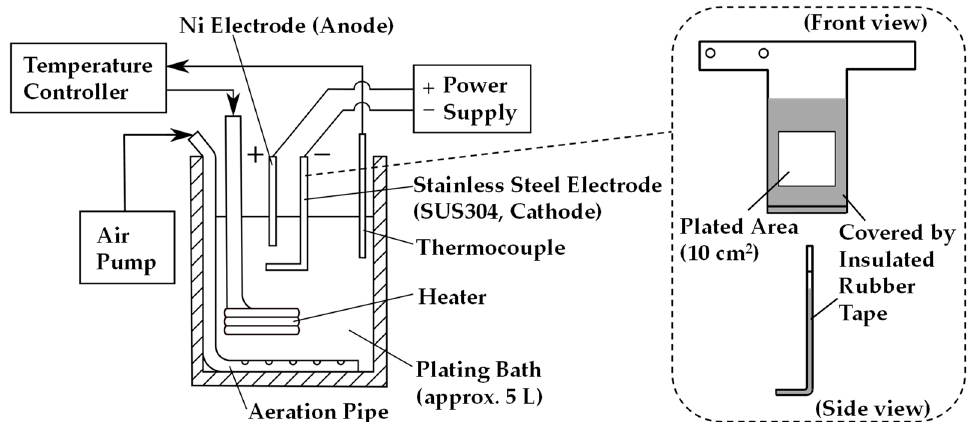
Figure 1. Schematic illustration of the plating equipment.